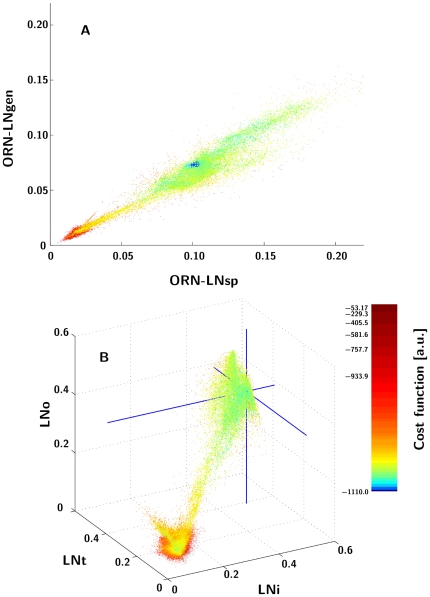
The cloud of data points (with cost function <0, n = 159,180) obtained in the simplex annealing of a basic conductance-based model with an ORN∶LN convergence rate of 1000.The colour of data points corresponds to the cost function value observed (see color bar). In each subfigure, the point with the best cost function is marked with a cross.